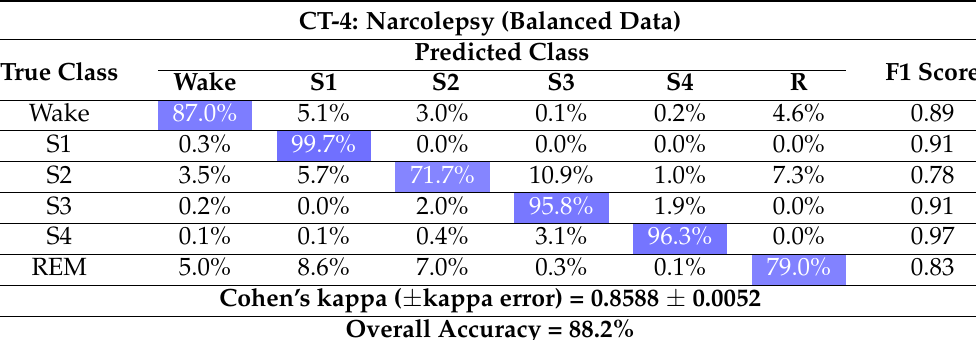
Table 16. Confusion matrix corresponding to sleep stage classification of narcolepsy patients with balanced data using the EBT classifier with 10-fold